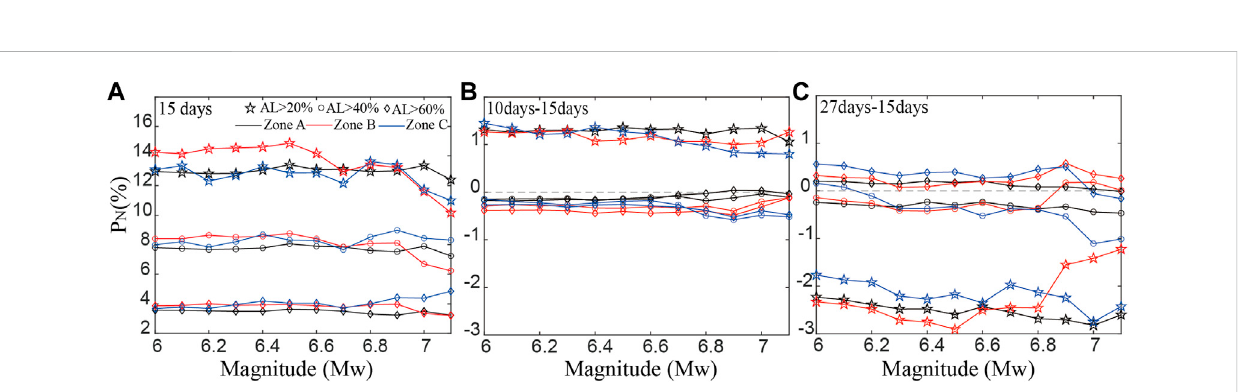
FIGURE 10 (A) Ionospheric anomalies occurrence rates of A > 20%, 40%, and 6% during background days; (B) The differences of ionospheric anomalies occurrenceratesbetweentheresultsof10-dayand15-daysliding windows; (C) Thedifferencesofionosphericanomaliesoccurrenceratesbetweenthe results of 27-day and 15-day sliding